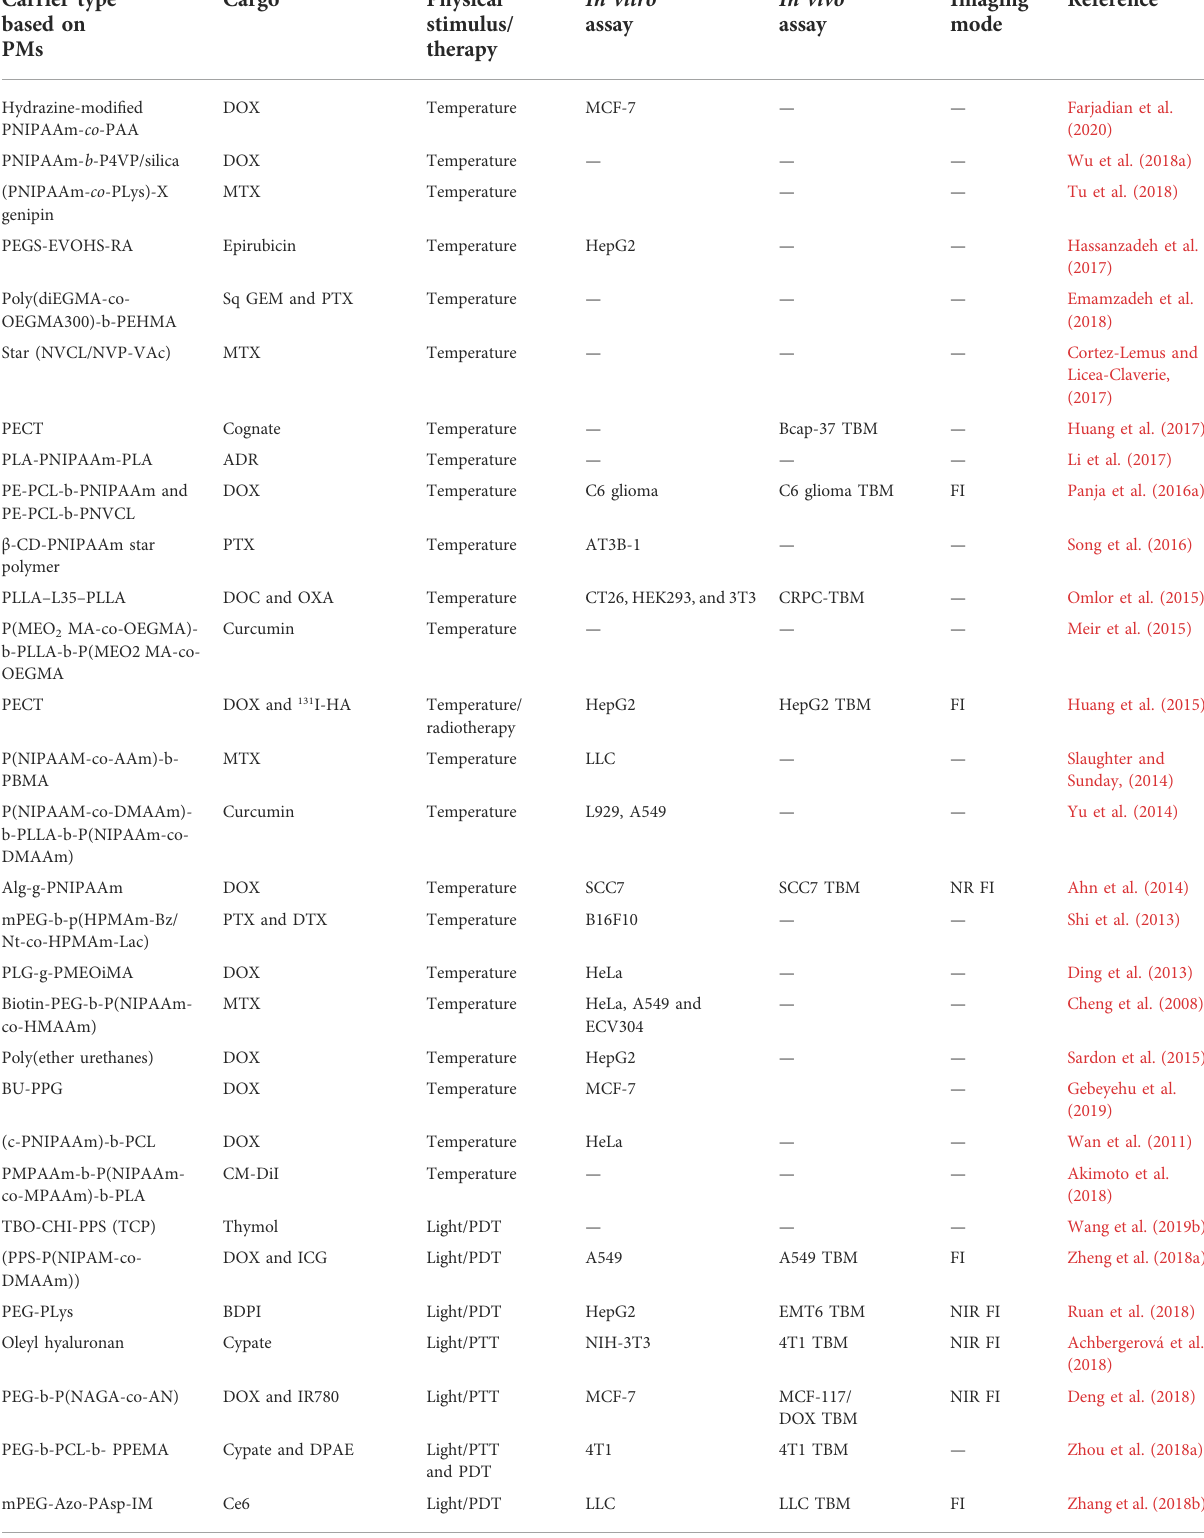
TABLE 1 Physically triggered polymeric micelles concerning the type of stimulus and cargo for in vitro and in vivo investigation, therapy, and diagnosis. Carrier type based